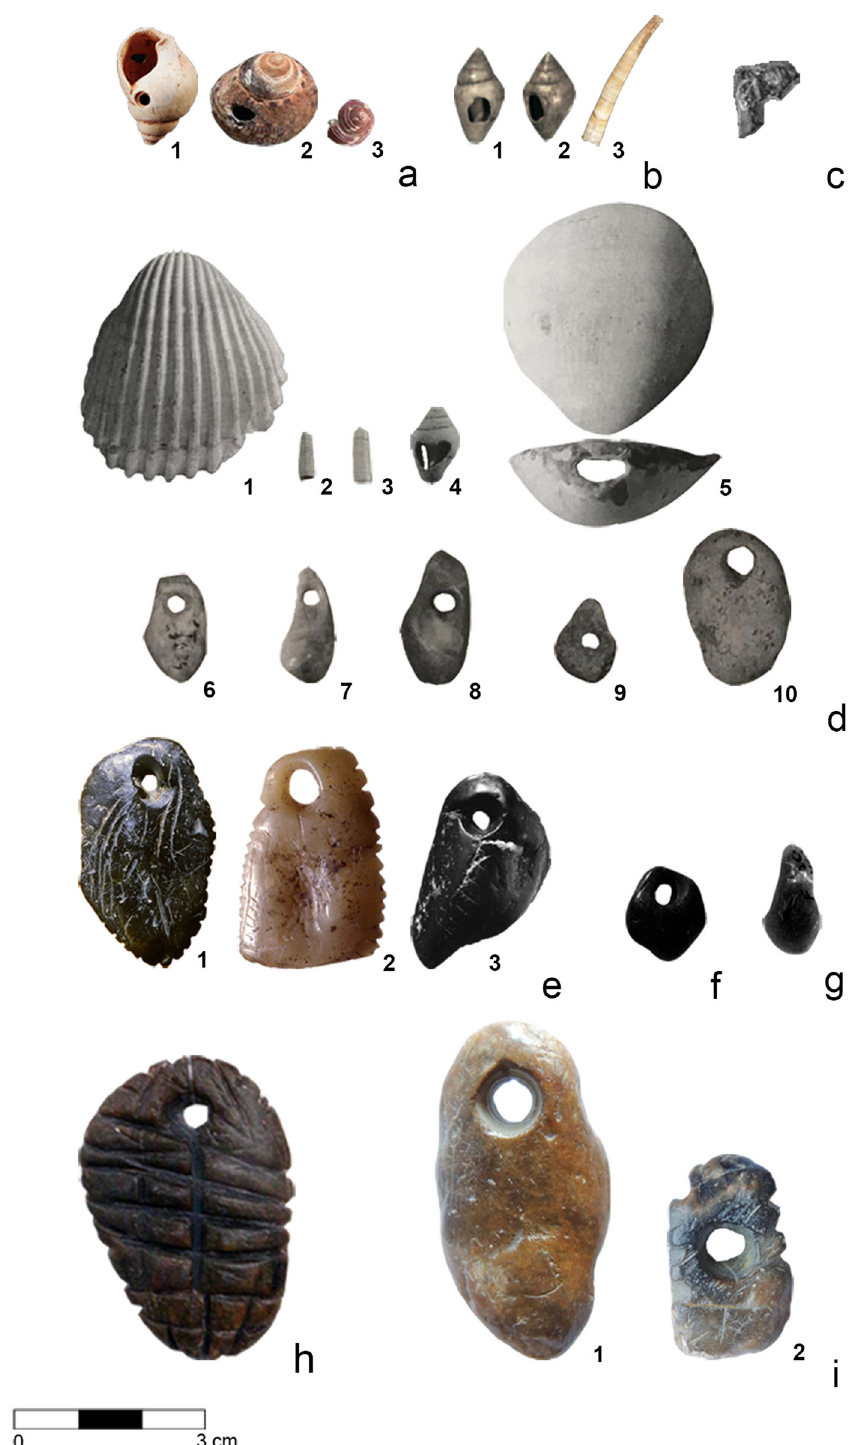
Figure 2: Selection of Italian pre - Neolithic ornaments. ( a ) Fumane Cave ( Peresani et al., 2019 ) ; ( b ) Riparo Gaban ( Borrello & Dalmeri, 2005; Cristiani, 2012 ) ; ( c ) Riparo Bombrini - Balzi Rossi ( Bertola et al., 2013 ) ; ( d ) Continenza Cave ( Colombo & Ser - radimigni, 2016 ) ; ( e ) Settecannelle Cave ( photograph by P. Ucelli Gnesutta ) ; ( f ) Polesini Cave ( Mussi, 1991 ) ; ( g ) Fossellone Cave ( Mussi, 1991 ) ; ( h ) Gavorrano ( photograph by Museo Archeologico di Massa Marittima ( Grosseto, Tuscany ) , CC BY - SA 4.0 ) ; and ( i ) Monterotondo ( photograph by A. Vassanelli ) . Elaboration by A.